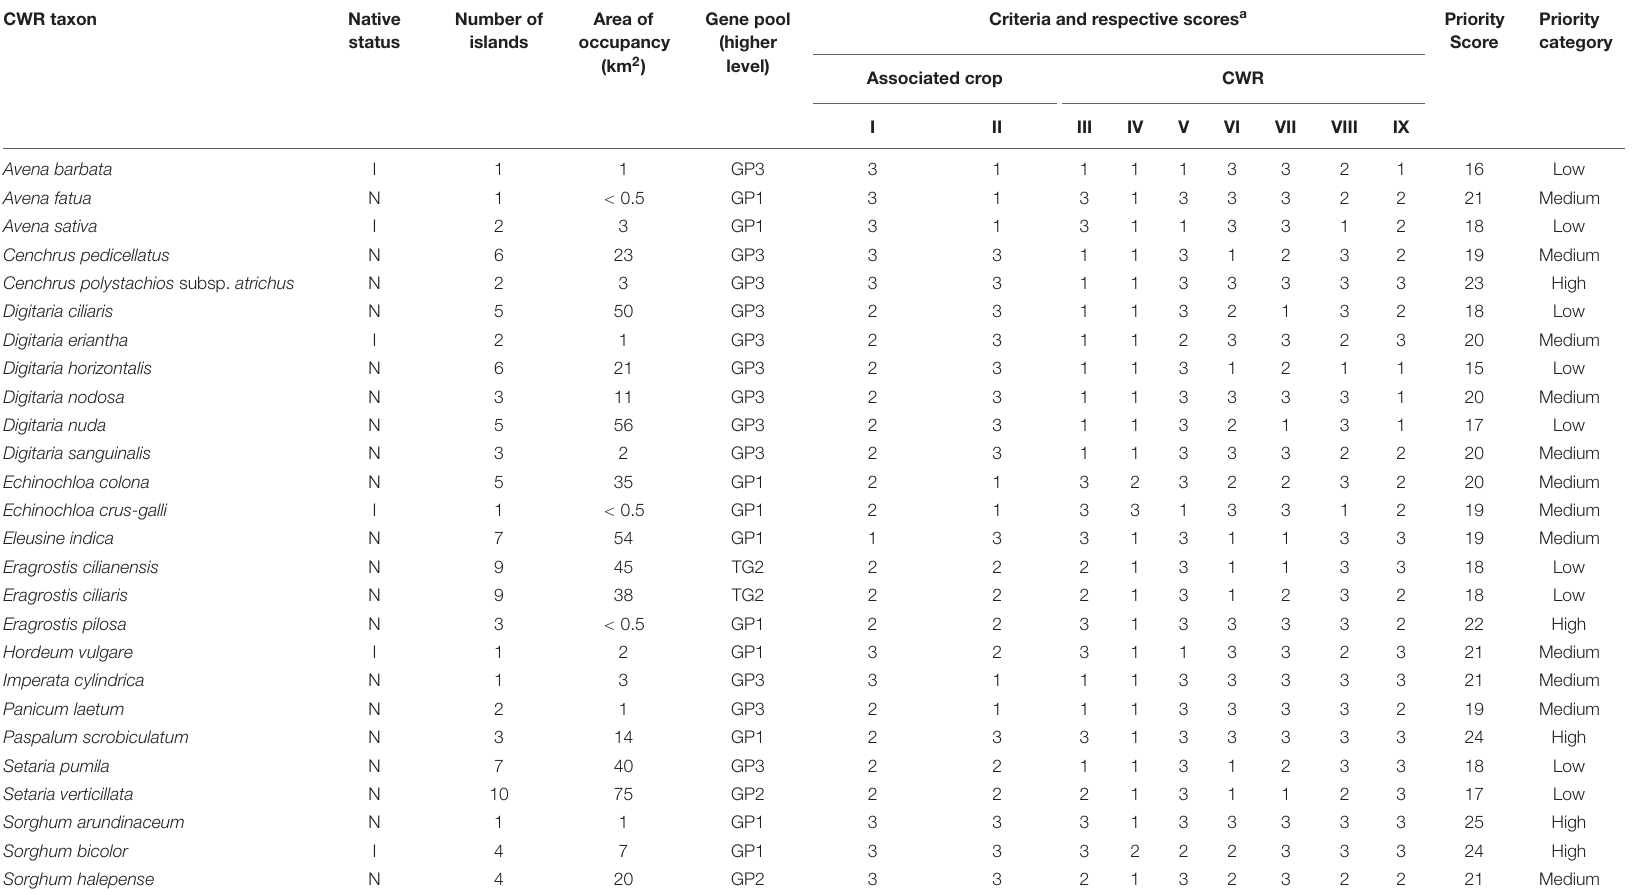
TABLE 3 | Poaceae CWR occurring in Cabo Verde, their native status, distribution, area of occupancy, gene pool, scoring of the prioritization criteria and conservation priority levels. CWR